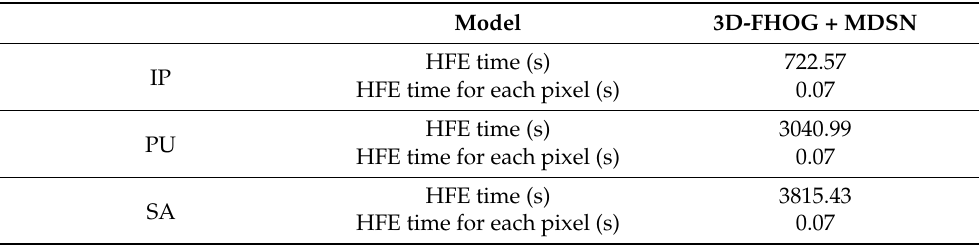
Table 12. Handcrafted feature extraction (HFE) time of 3D-FHOG + MDSN on the three HSI data sets with three labeled samples per